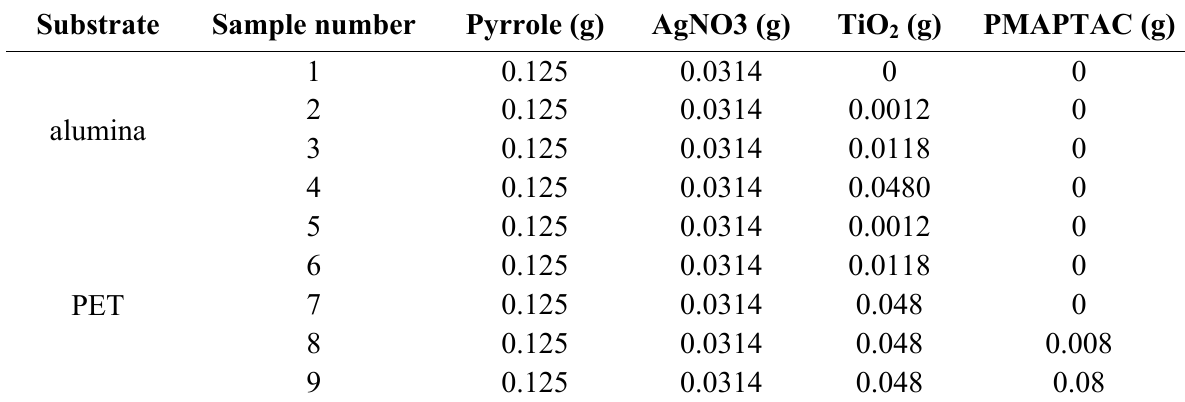
Table 1. Composition of the composite films used to prepare humidity sensors (data taken from